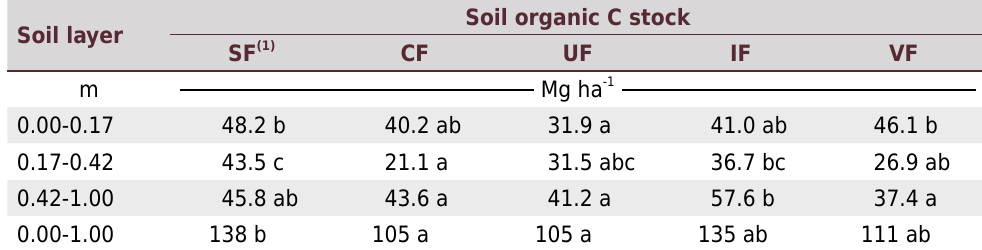
138 b 105 a 111 ab (1) All under native forest: CF = Coruripe; UF = Umbaúba; VF = Nova Viçosa; SF = Sooretama; IF = Itaboraí. Different lowercase letters in a line indicate differences (p<0.05) among different forest areas at each soil layer. The C stock was calculated according to Veldkamp